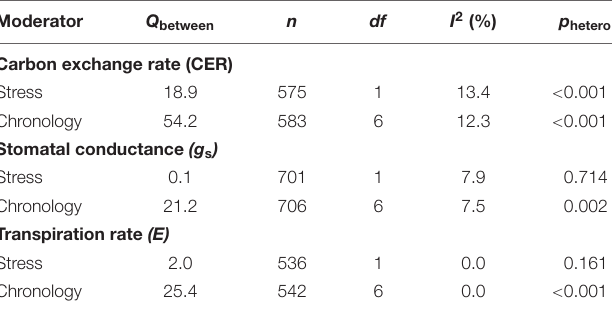
TABLE 1 | Categorical meta-analysis of three gas exchange summary